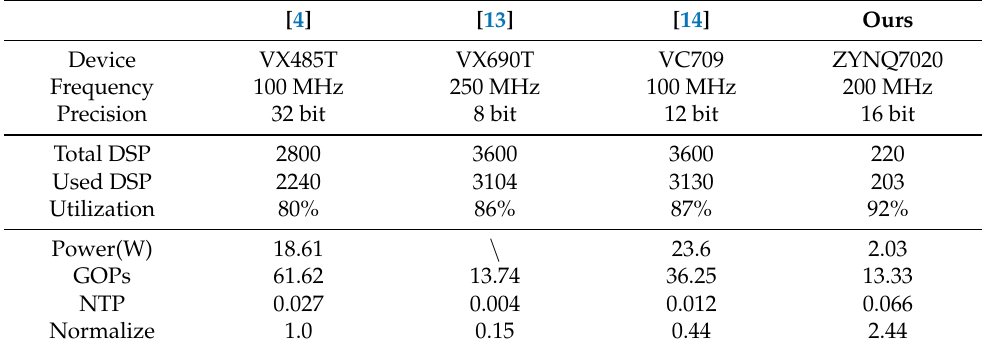
Table 5. Performance evaluation and comparison with other